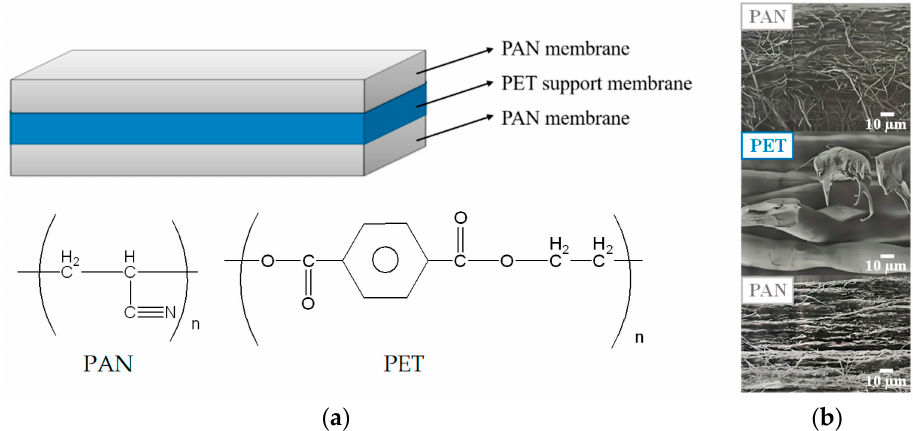
Figure 1. ( a ) Structure of the 3-layer PAN membrane used in this work and ( b ) cross-section SEM images for each